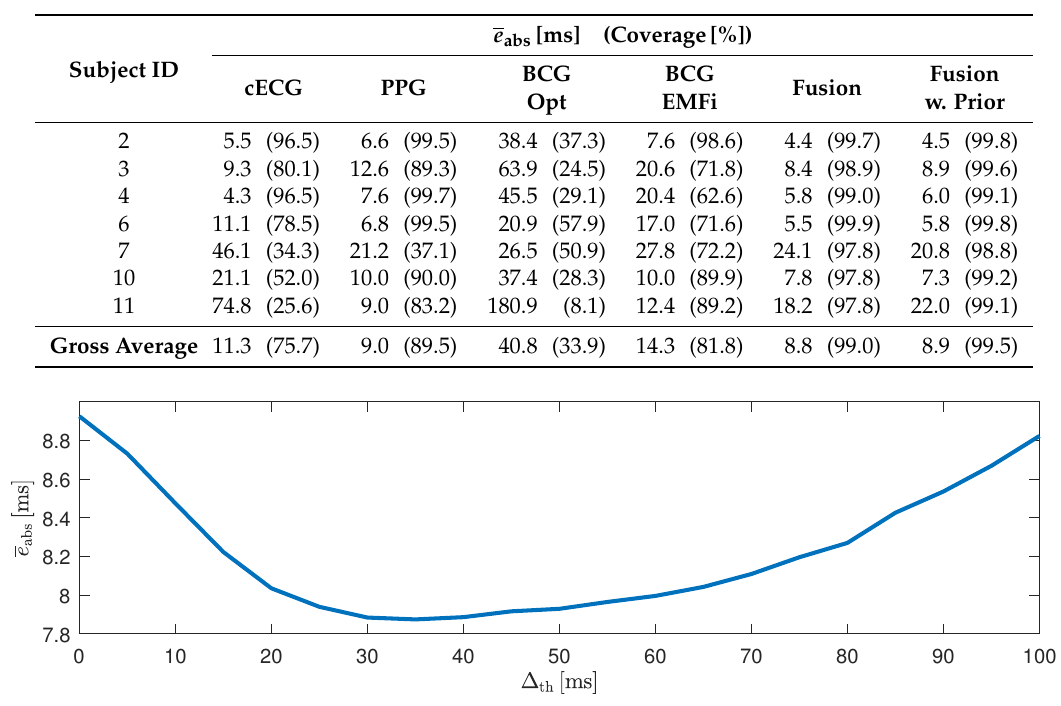
Table 6. Mean absolute interval estimation error ( e abs ) in milliseconds and coverage in percent for all subjects in the video scenario.